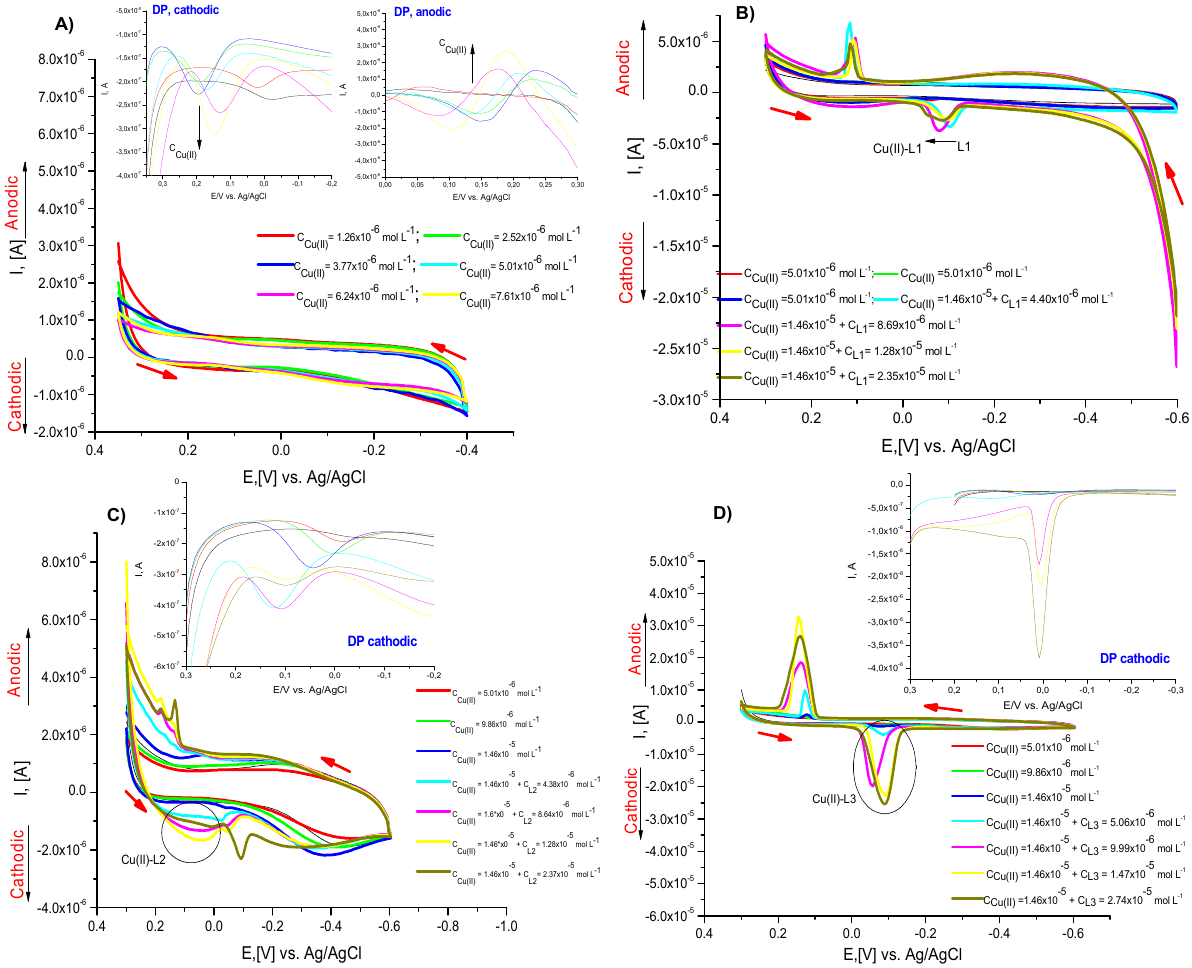
Figure 11. Ciclyc voltamperograms and differential pulse voltamperograms (inserted graphics) of free copper (II) ions ( A ) and Cu(II)-L complexes ( B – D ) in ammonium (pH 10.35, 0.1 mol L − 1 ) buffer solutions at Pt working electrode and Ag/AgCl, KCl (3 mol L − 1 ) as reference electrode; scan rate: 1.00 V s − 1 .